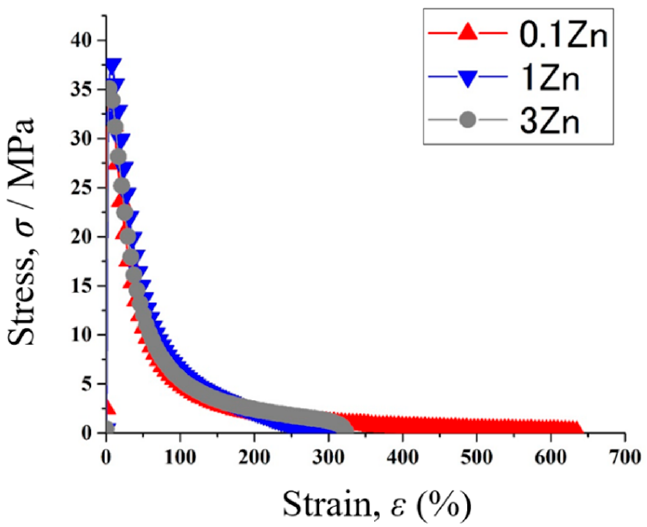
Figure 11. Stress–strain curves of various Sn-40Bi-Zn alloys at 333 K under a strain rate of 5.25 × 10 − 4 s − 1 .